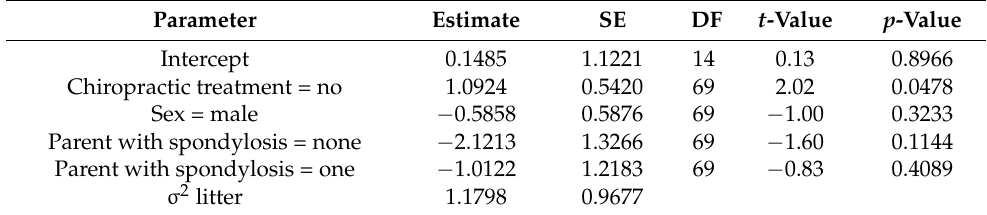
Figure 3. Frequency distribution for the scoring of spondylosis in one-year-old Boxers given veteri- nary chiropractic treatment (treated) or no treatment (control) as puppies. The number of dogs in each score category is shown next to the bars. Table 2. Parameter values for the model testing for spondylosis occurrence in one-year-old Boxers given repeated chiro- practic treatment as puppies or no treatment. The default settings (parameter estimate = 0) for the categorical fixed effect parameters are: chiropractic treatment = yes; sex = female; and both parents having a score ≥ 1 according to the Norwegian scoring system.